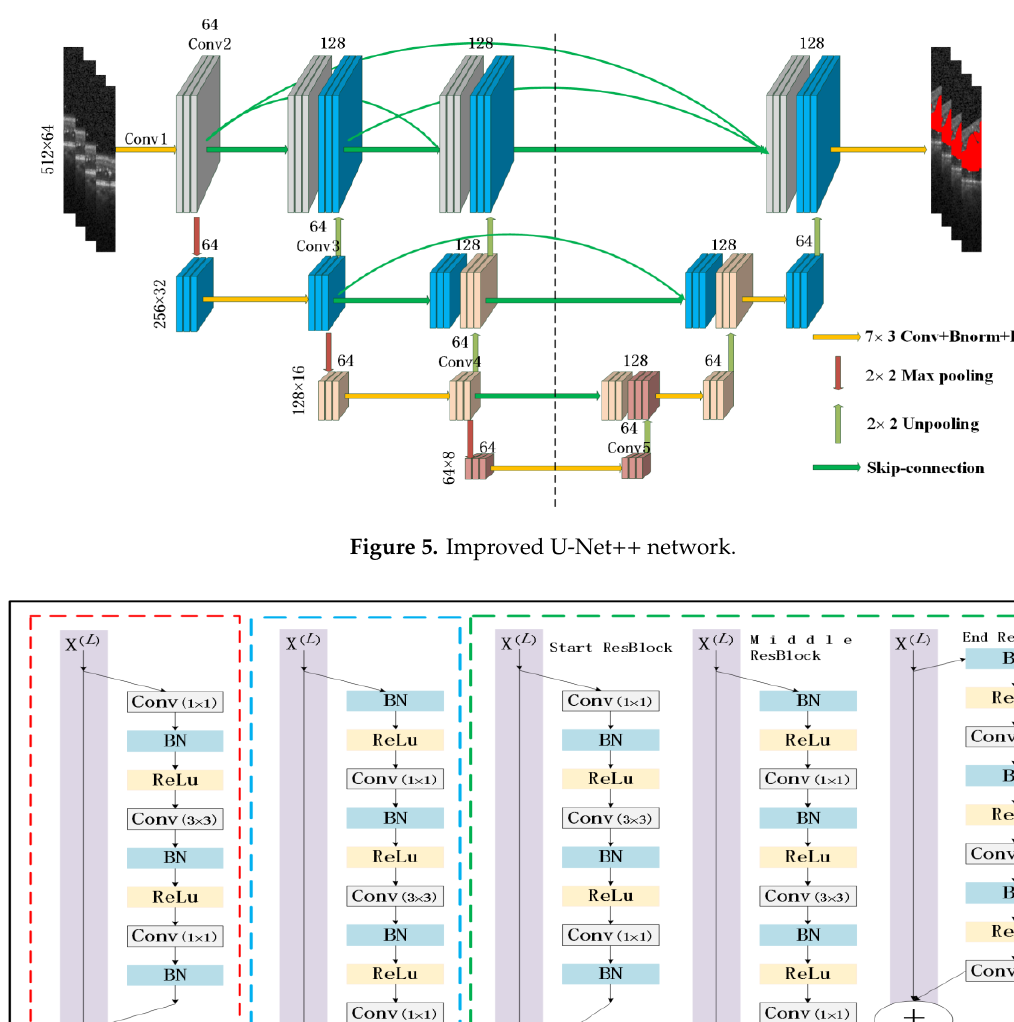
( b ) Figure 7. Comparison of projection shortcut: ( a ) original projection shortcut (inside the red frame); ( b ) the improved projection shortcut (inside the green frame). As shown in Figure 7b, ResNeSt considers all information from feature mapping. ResNeSt first uses the 3 × 3 max pooling layer of stride = 2, then uses 1 × 1 convolution of stride = 1 for channel projection, connecting with BN and finally selecting the element with the highest activation degree in the next step in order to reduce information loss.